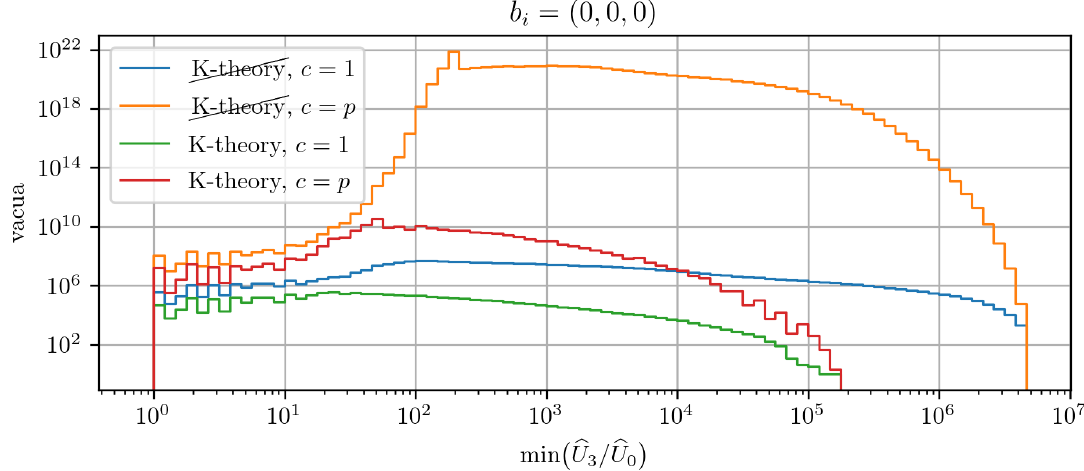
Figure 3. Number of vacua for T = 8 and b i = (0 , 0 , 0) as a function of the minimal value of b U 3 / b U 0 ≥ 1 allowed by the SUSY-Y